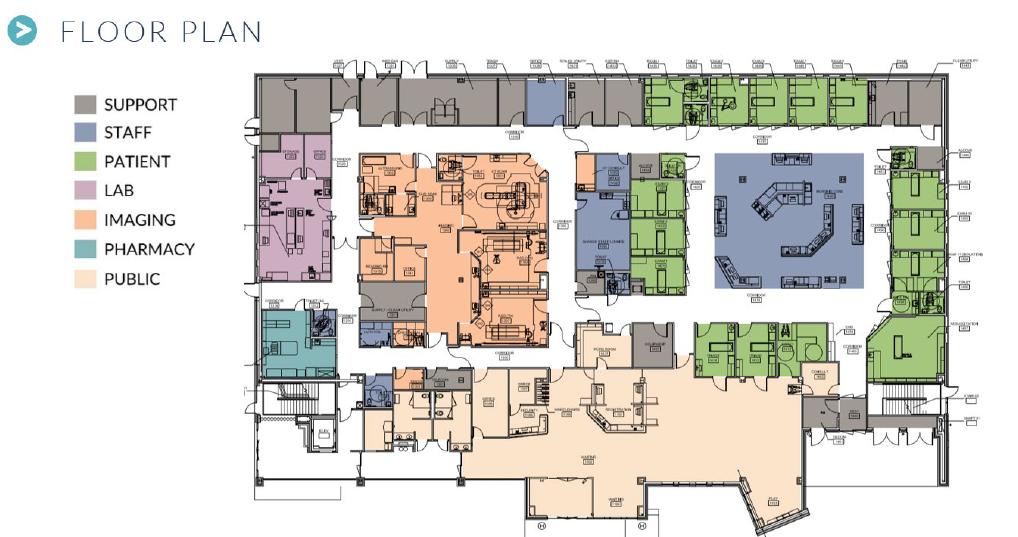
Figure 1 The Emergency Department layout and room functions (Image Copyright: